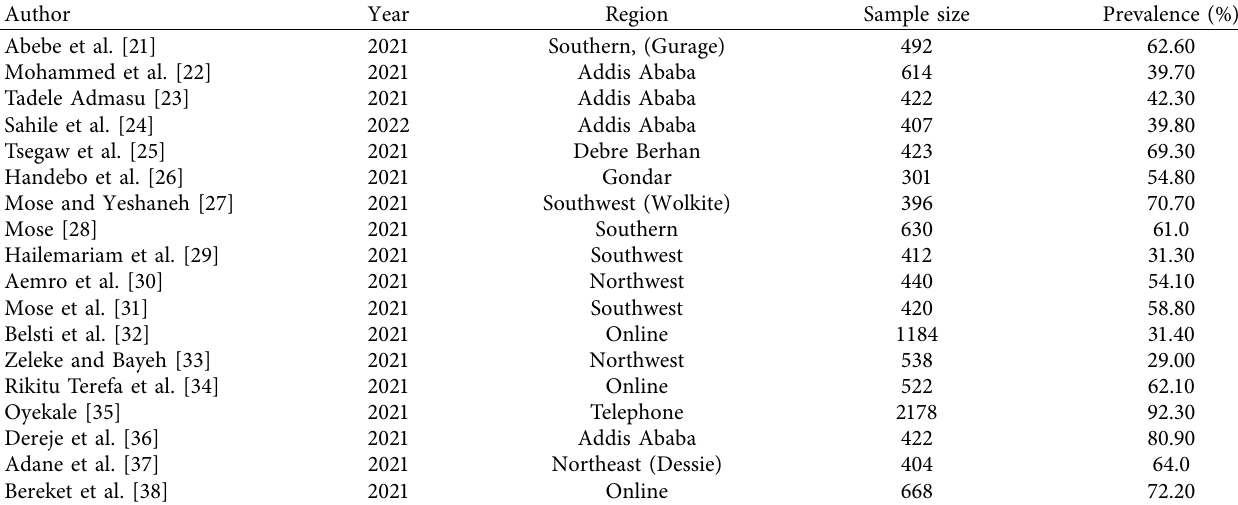
Table 1: Characteristics of included studies, their area, sample size, and